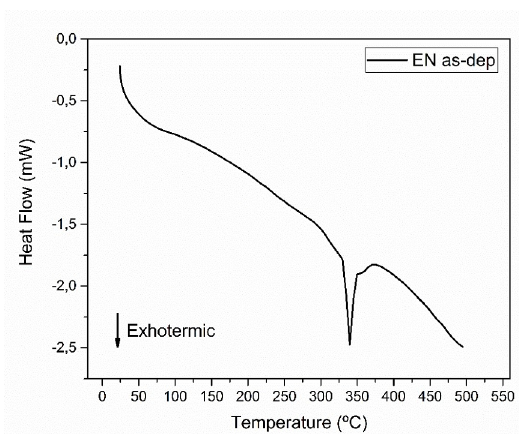
Figure 1. DSC test in Ni-P as-deposited